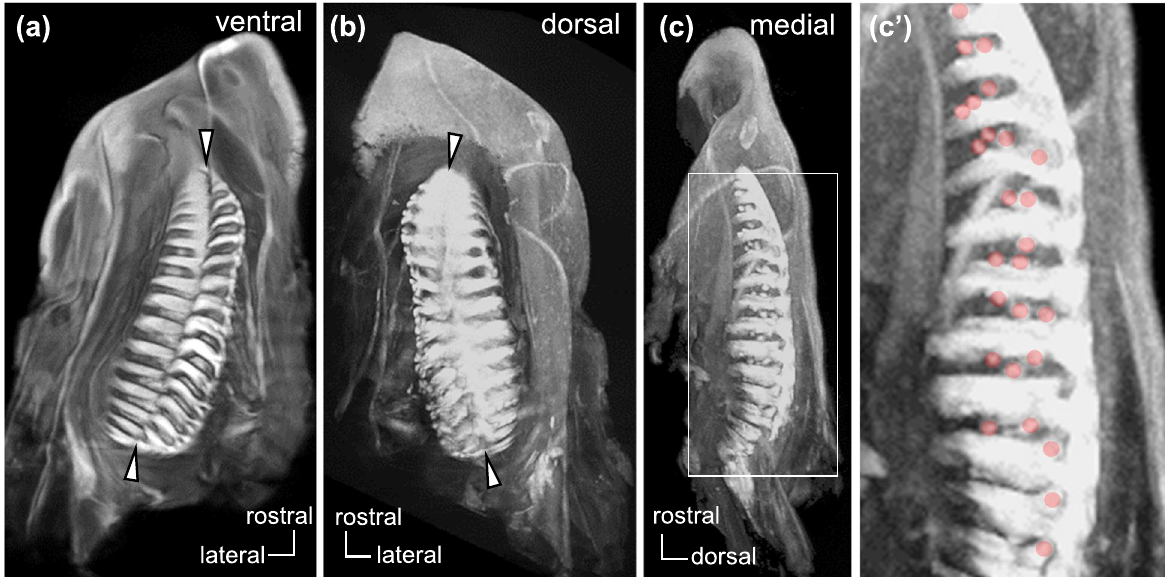
Fig. 1 Diffusible iodine-based contrast-enhanced computed tomography images of the olfactory organ in P. aethiopicus . The right olfactory organ viewed from the ventral ( a ), dorsal ( b ) and medial ( c ) aspects. Higher magnification view of ( c ) is shown in ( c’ ). Lamellae were arranged on the medial and lateral sides of the midline raphe (arrowheads). Recesses were abundantly present at the base of lamellae. The recesses are highlighted by red-shaded circles in ( c’